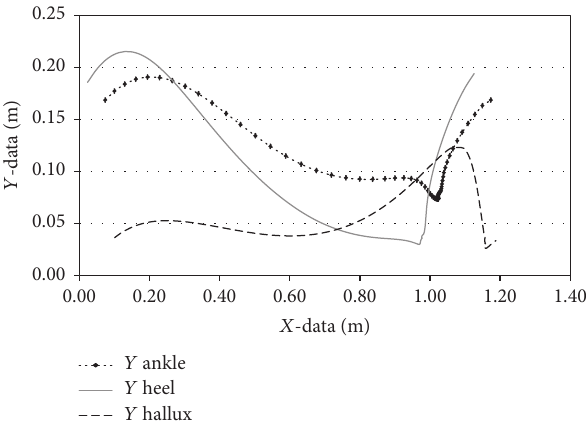
Figure 4: Kinematic model angles: 𝜂 from the ground parallel to hallux and 𝜃 from ground parallel to heel [9]. Figure 5: Spatial trajectory in transverse plane during gait